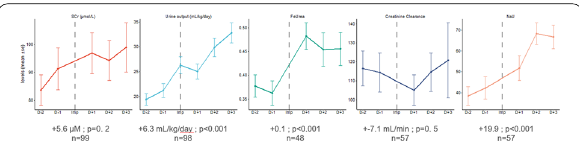
Table 1. Multivariate analysis for AKI